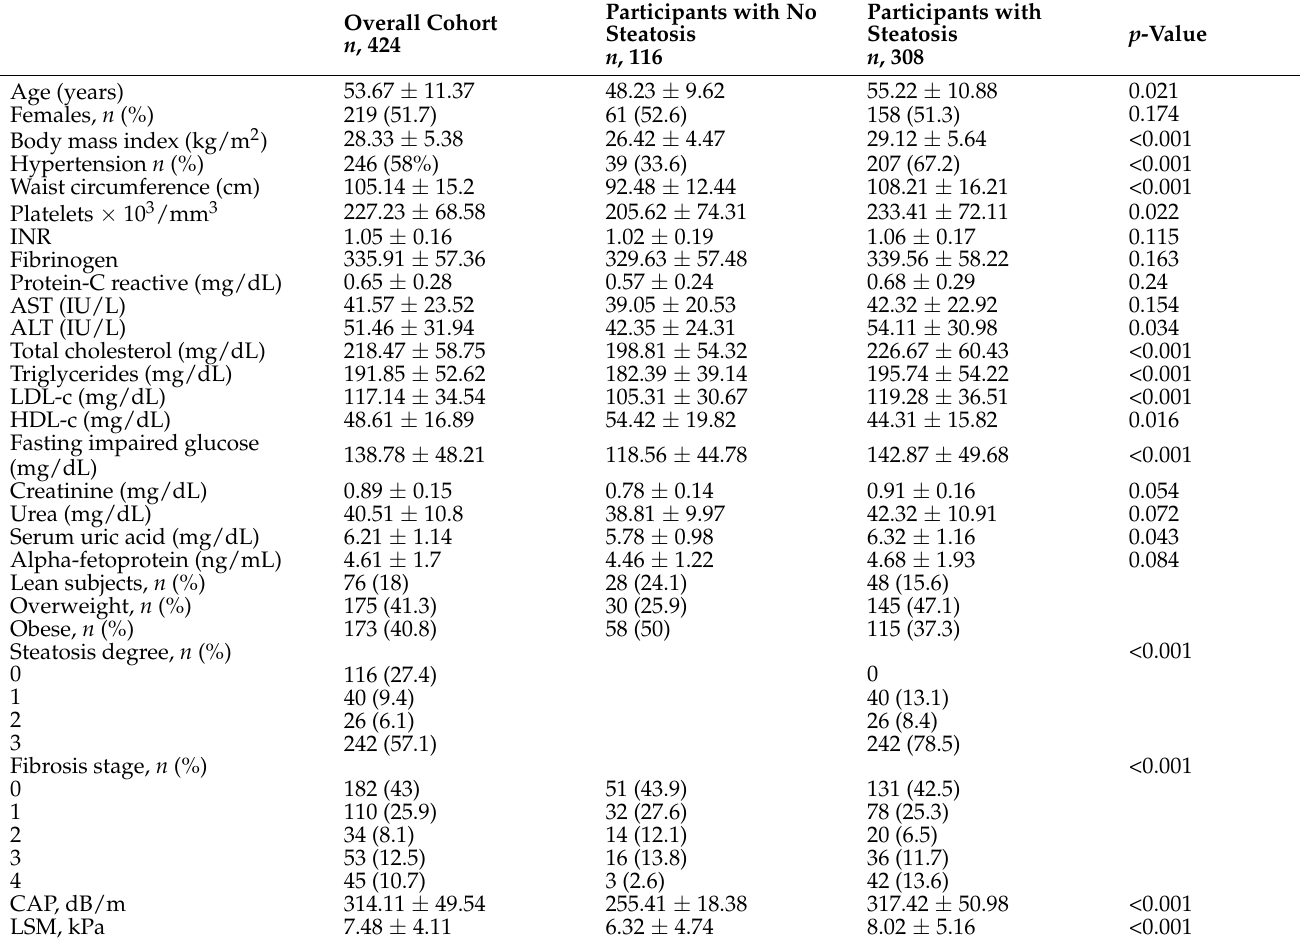
Table 1. Baseline characteristics of the study group according to the presence of liver